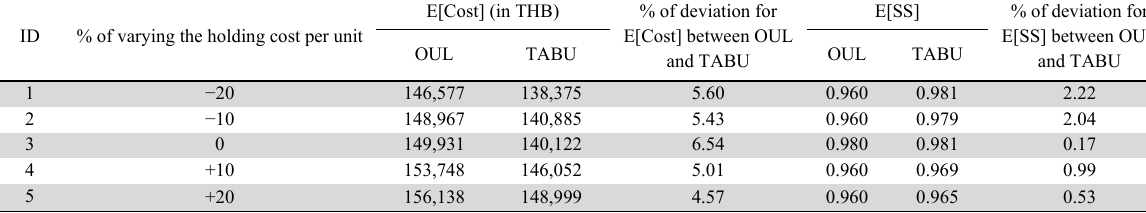
Sensitivity analysis of the efficiency of TABU for different holding costs